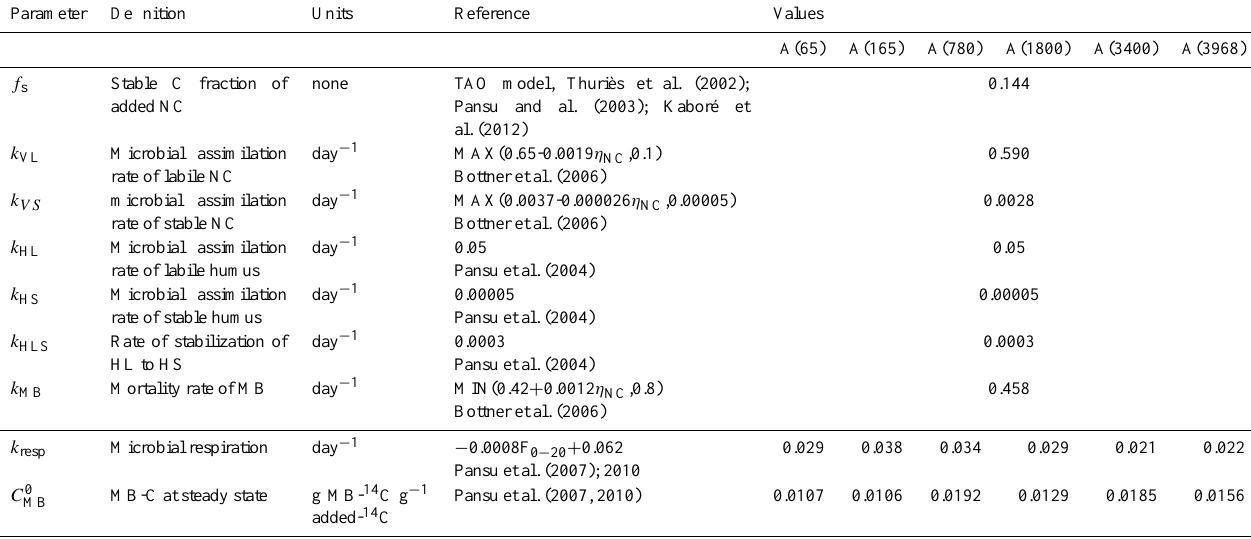
Table 3. Parameter values used in the MOMOS-C model (Pansu et al., 2010) and retained in this N study. Parameter